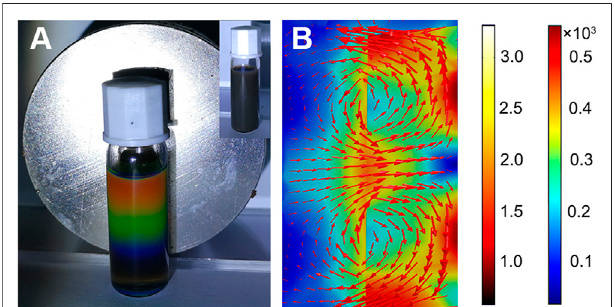
FIGURE 9 | (A) Photo of the rainbow-like colors effect displayed with a NdFeB magnet with circular disk shape. Inset: A bottle of Fe 3 O 4 @PSSMA@ SiO 2 CNCs without magnet placed (5 mg/ml in aqueous solution and the size is 220 nm). (B) The EMF strength distribution simulated by COMSOL Multiphysics 5.3. Copyright © 2018 American Chemical